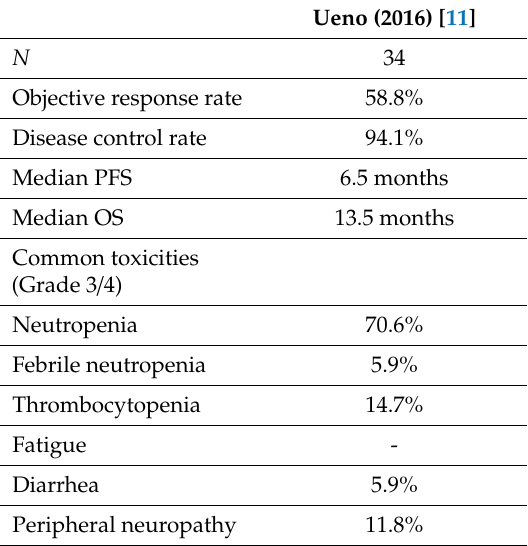
Table 2. E ffi cacy and safety gemcitabine plus nab-paclitaxel for metastatic pancreatic cancer in the Japanese phase I / II